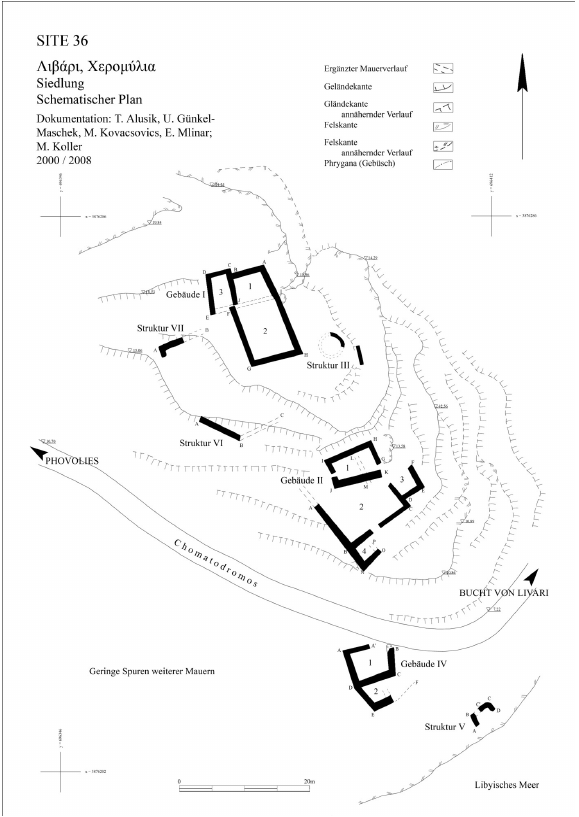
Figure 2. The schematic plan of the site of Livari Cheromylia created by N. Schlager et al. (will appear in ÖJh 2010). © Norbert